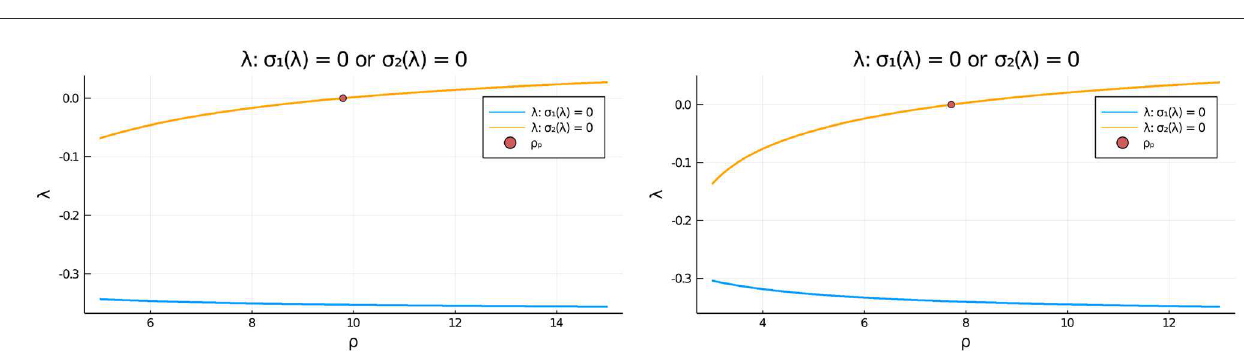
FIGURE8 Plots of the numerically computed largest roots of σ 1 ( λ ) 0 and σ 2 ( λ ) 0 vs. ρ , as defined in Equation (3.20), that determine the linear stability properties = = to either in-phase e (1,1) T or anti-phase q 2 (1, 1) T eigenperturbations of the symmetric steady-state solution, respectively. Left: for d u = = − have ρ p 9.79168. Right: for d u 0.05 we have ρ p 7.70971. Observe that in-phase eigenperturbations are always linearly stable, whereas anti-phase ≈ = ≈ eigenperturbations are linearly stable only on the range ρ < ρ p before the pitchfork point ρ p . Parameters: D u